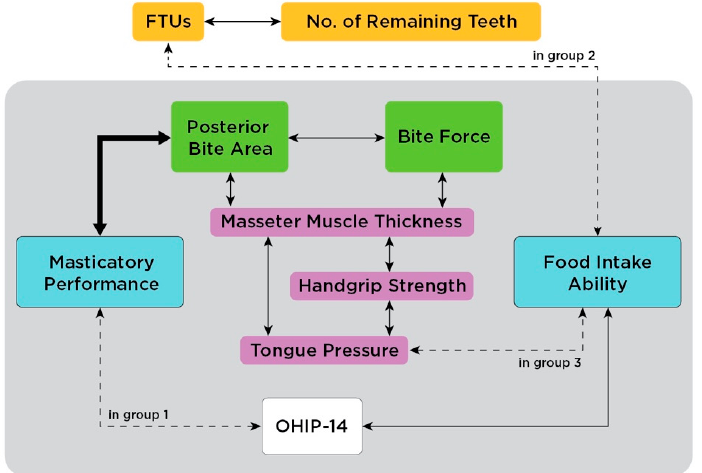
Figure 2. Summary of the significant interrelationships in this study among various factors of masticatory function.